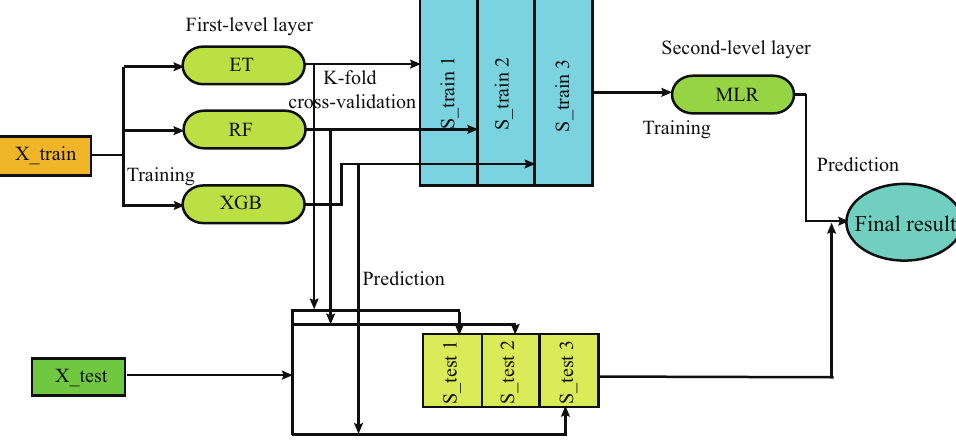
Figure 4. The hybrid model